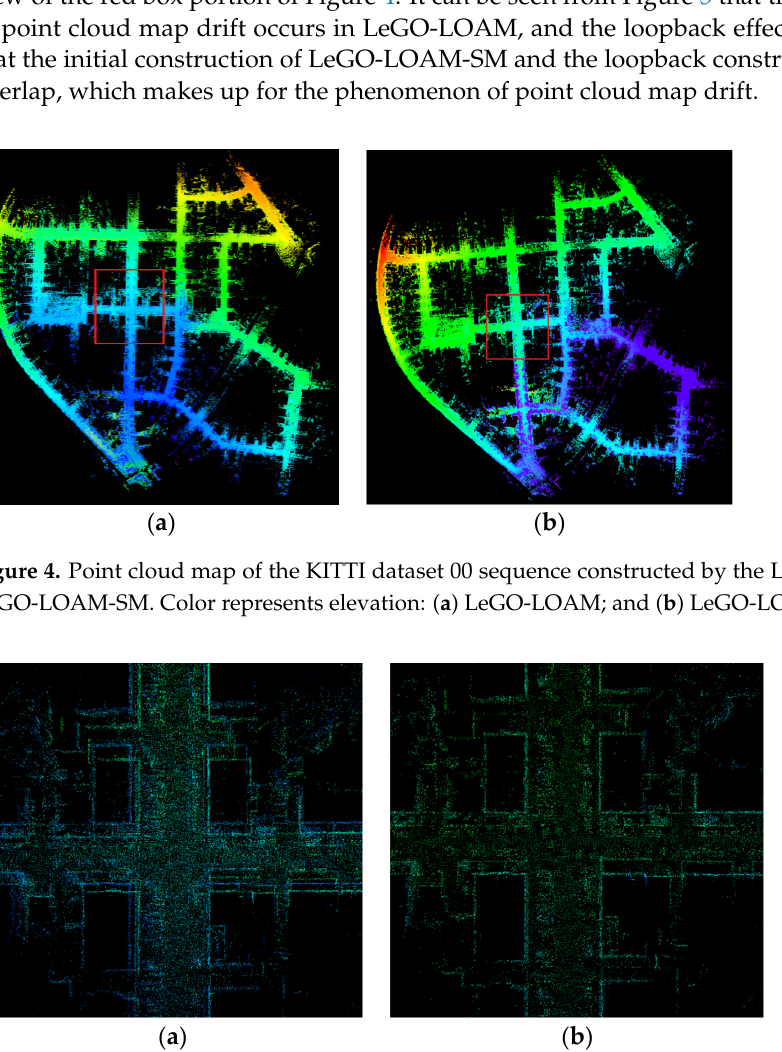
Figure 5. Partial enlarged view of the red box portion of Figure 4: ( a ) for LeGO-LOAM; ( b ) for LeGO-LOAM-SM.